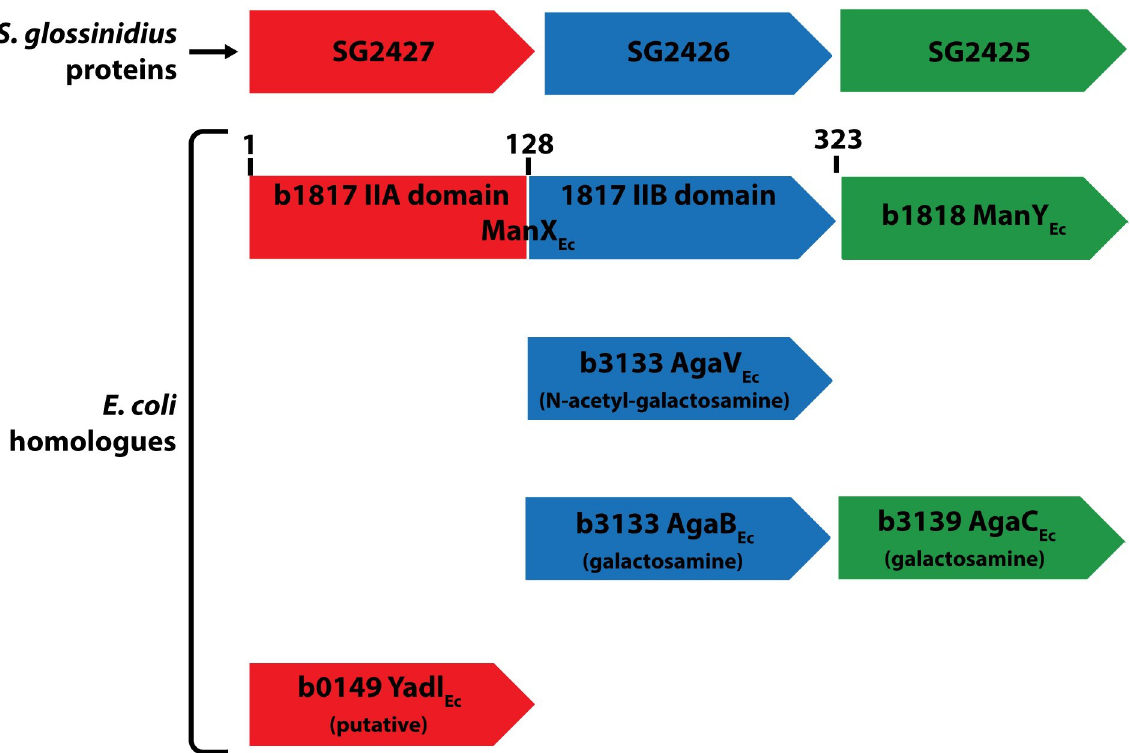
Fig 5. Comparison of Sgm putative PTS proteins encoded by SG2425-2427 with E . coli K12 proteins. The three putative S . glossinidius proteins are shown at the top in red, blue, and green, with their E . coli K12 homologues shown below in matched color coding.